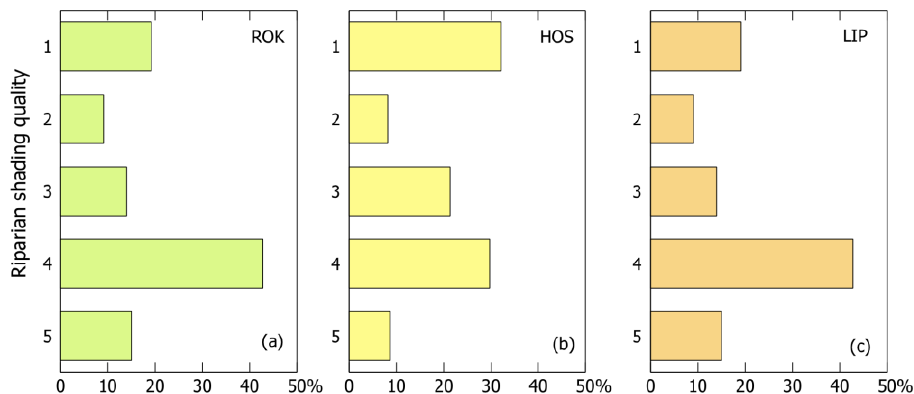
Figure 11. Assessment of the riparian shading indicator. Share of riparian shading quality classes on the restored stream length. ( a ) ROK, ( b ) HOS, and ( c ) LIP. Data: UAV monitoring, 2021.